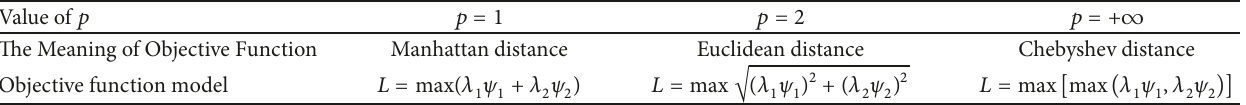
Table 1: Value of 𝑝 corresponding to different distance calculation